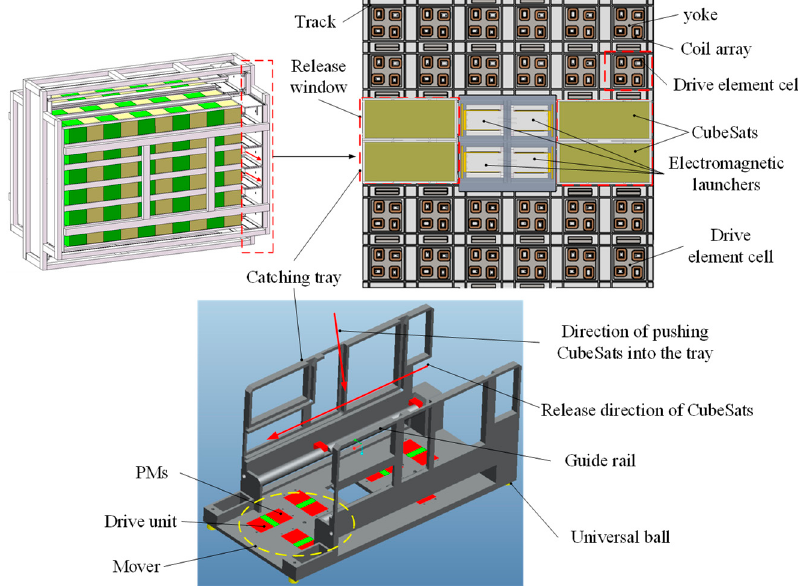
Figure 2. Structure of the electromagnetic conveying platform.